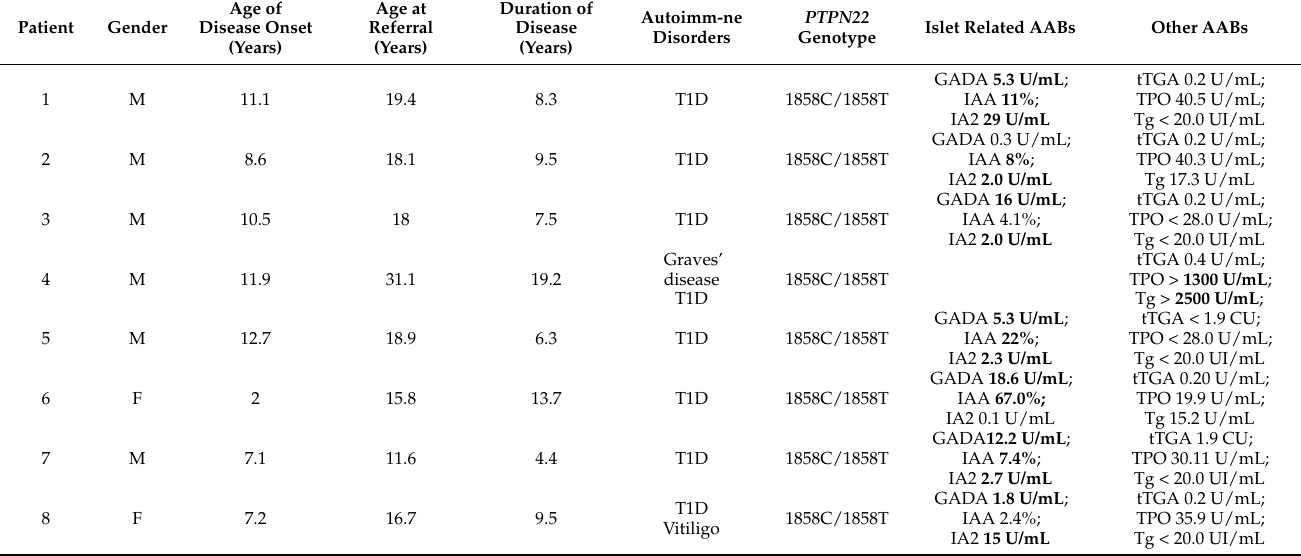
Table 1. Demographic, genetic and clinical characteristics of patients of the present